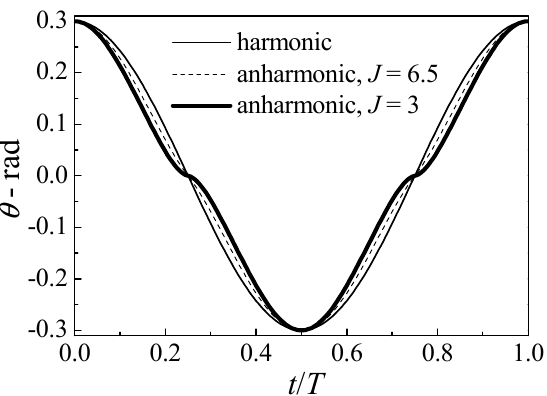
Figure 3. Pitching angle curve comparison when the heave motion is simple harmonic while the attack angle curve is anharmonic.